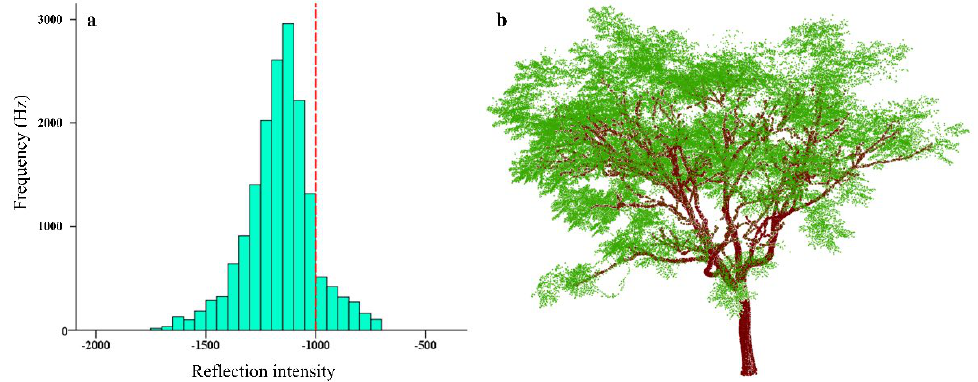
Figure 4. ( a ) Point cloud reflection intensity histogram, ( b ) final point cloud classification results for an individual Koelreuteria paniculate